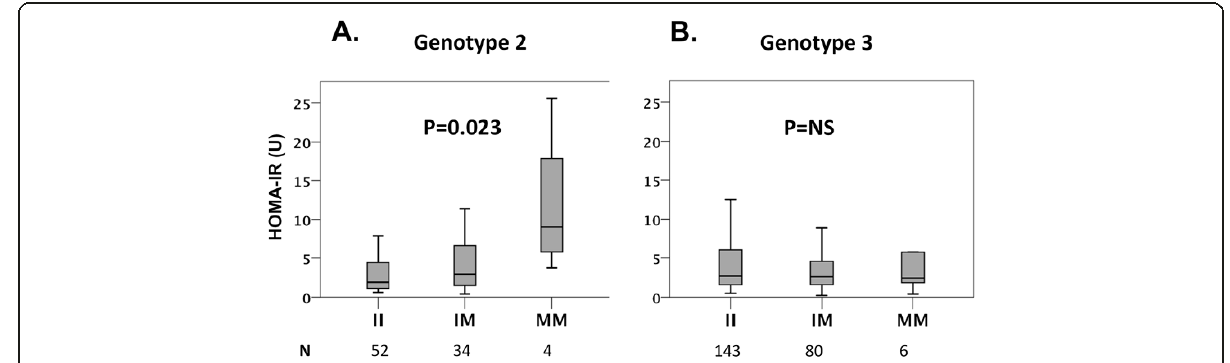
Figure 1 Homeostasis model assessment for insulin resistance (HOMA-IR) in HCV genotype 2 (A) and genotype 3 (B) infected patients, stratified by the PNPLA3 I148M genotype. P values were calculated using linear regression after logarithmic transformation of HOMA-IR values and adjusted for age, gender and